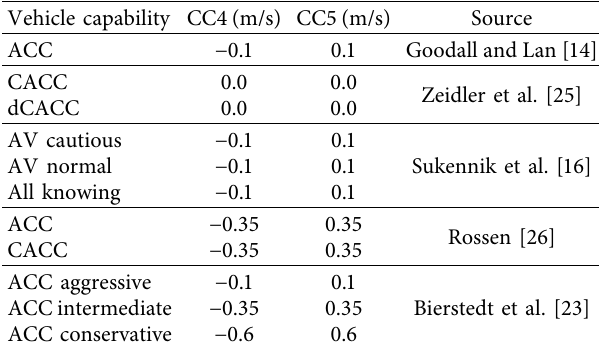
Table 3: Negative (CC4) and positive (CC5) “following” thresholds for the Wiedemann 99